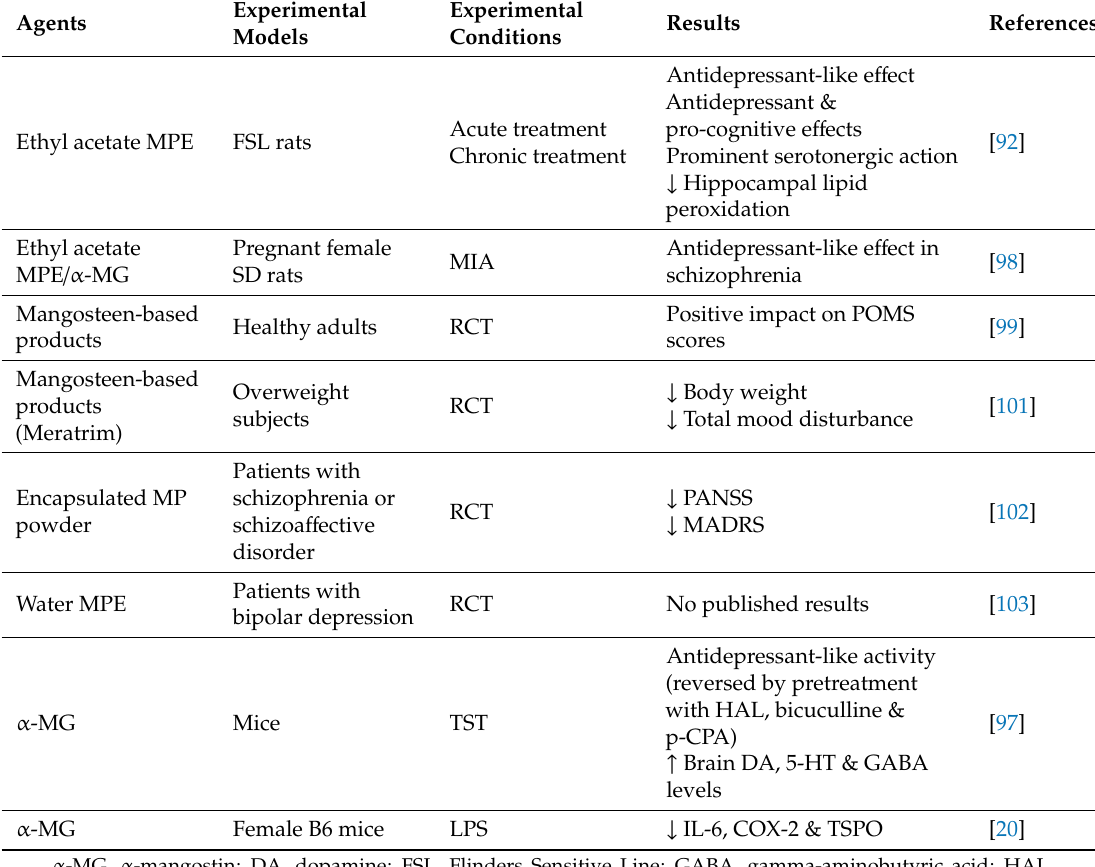
Table 3. Pharmacological e ff ects of MP-derived agents in depression